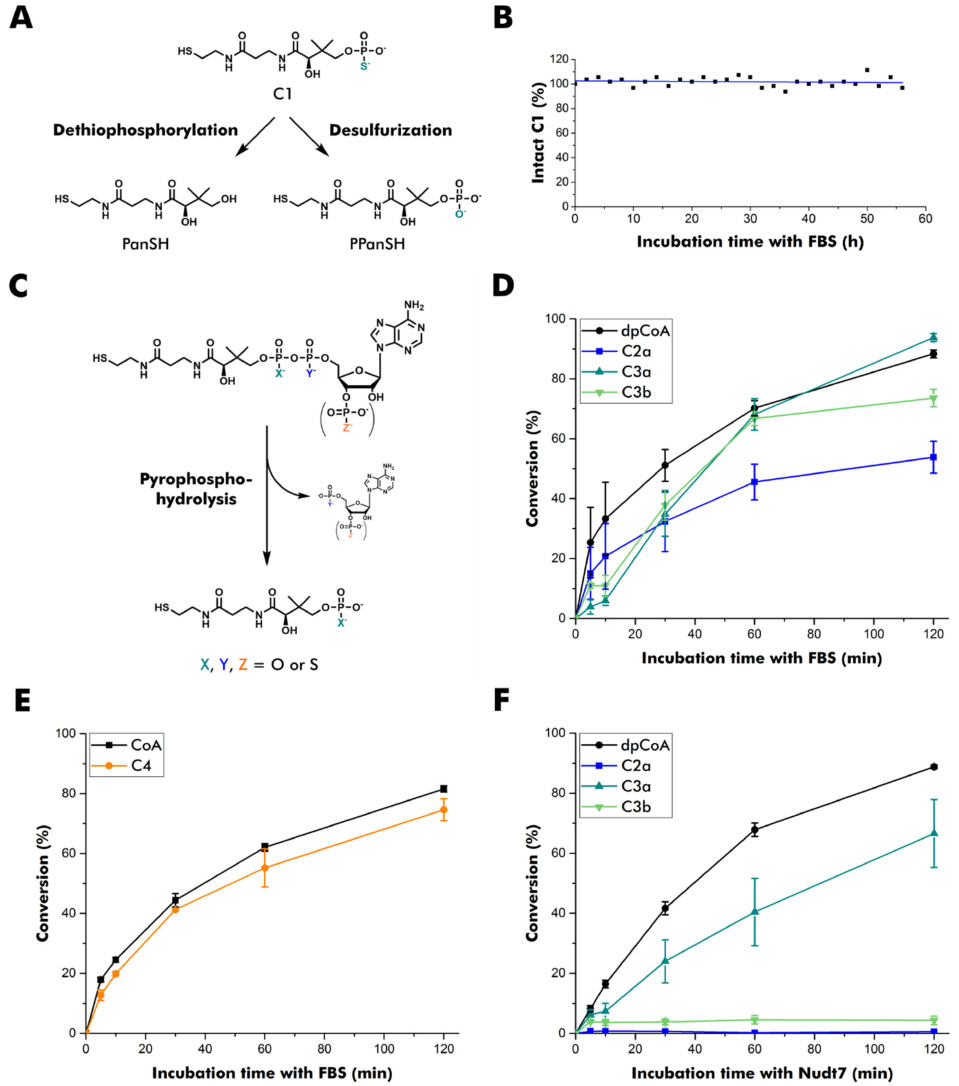
Figure 2. Stability of thiophosphate analogs of PPanSH, dpCoA, and CoA. ( A ) Overview of potential degradation pathways of C1. PanSH: pantetheine. ( B ) Stability of C1 in fetal bovine serum (FBS). The sample was monitored by 31 P NMR spectroscopy. The signal of C1 was integrated and normalized to the phosphate peak arising from FBS. ( C ) Overview of pyrophosphate hydrolysis of dpCoA and CoA as well as thiophosphate analogs thereof. ( D ) Quantification of the conversion of dpCoA and C2a to PPanSH or C3a and C3b to C1 after incubation in FBS. ( E ) Quantification of the conversion of CoA and C4 to PPanSH after incubation in FBS. ( F ) Quantification of the conversion of dpCoA and C2a to PPanSH or C3a and C3b to C1 after incubation with human Nudt7. ( D – F ) Thiol compounds are quantified after conjugation to the fluorescence dye 7-diethylamino-3-(4-maleimidophenyl)-4-methyl- coumarin (CPM) and subsequent RP-HPLC separation. The peak heights of CPM conjugates were measured at 465 nm emission, and the product-to-substrate ratio was calculated. Error bars represent the standard deviation (n =